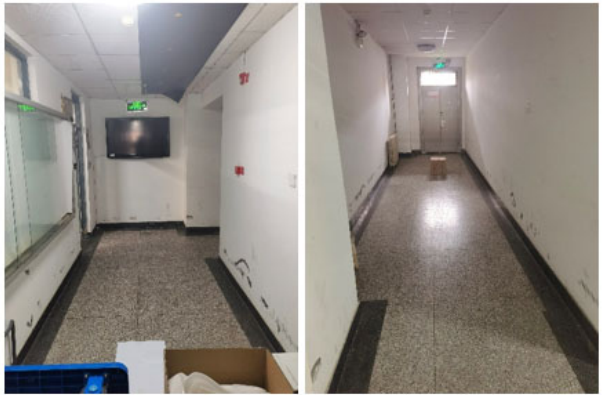
Figure 18. “L” shaped long corridor.